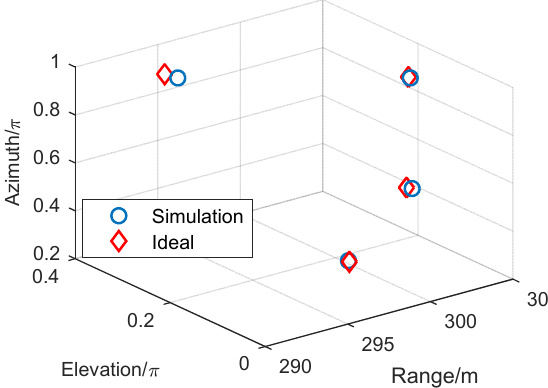
Figure 11. The 3-D imaging result.